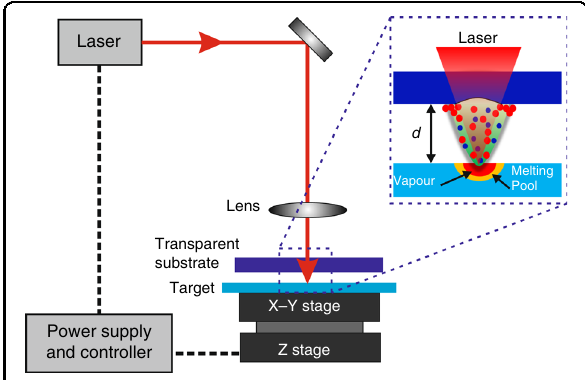
Fig. 1 Schematic of LIPAA setup. The setup mainly consists of a laser, a transparent substrate and a target. The laser beam passes through the the transparent substrate and irradiates on the target which is located behind the transparent substrate. The target is highly absorptive to the laser energy and laser action on the target surface can induce an amount of plasma. The plasma fl y towards the rear surface of the substrate at a high speed and assist laser ablation. d is the distance between the transparent substrate and the